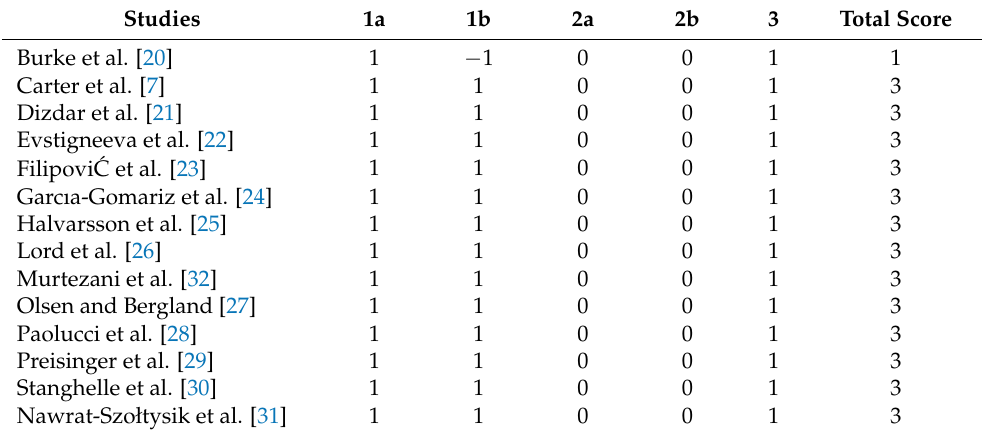
Table 2. Methodological quality assessment (Jadad